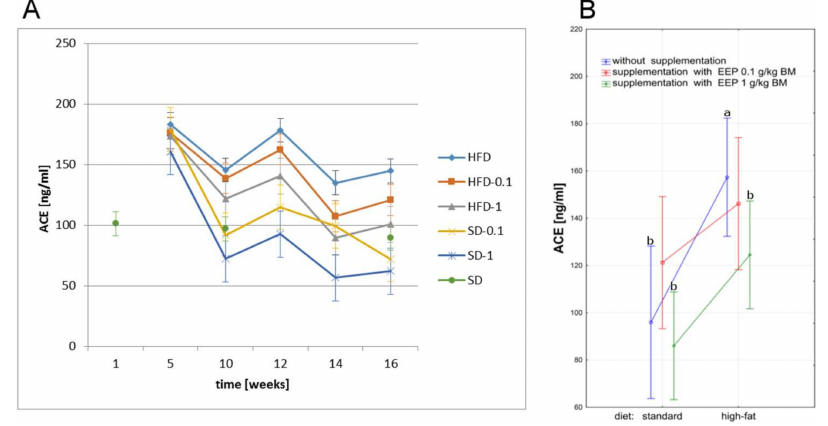
Figure 6. Angiotensin-converting enzyme level in C 57 BL 6 mice. ( A ) Aangiotensin-converting enzyme